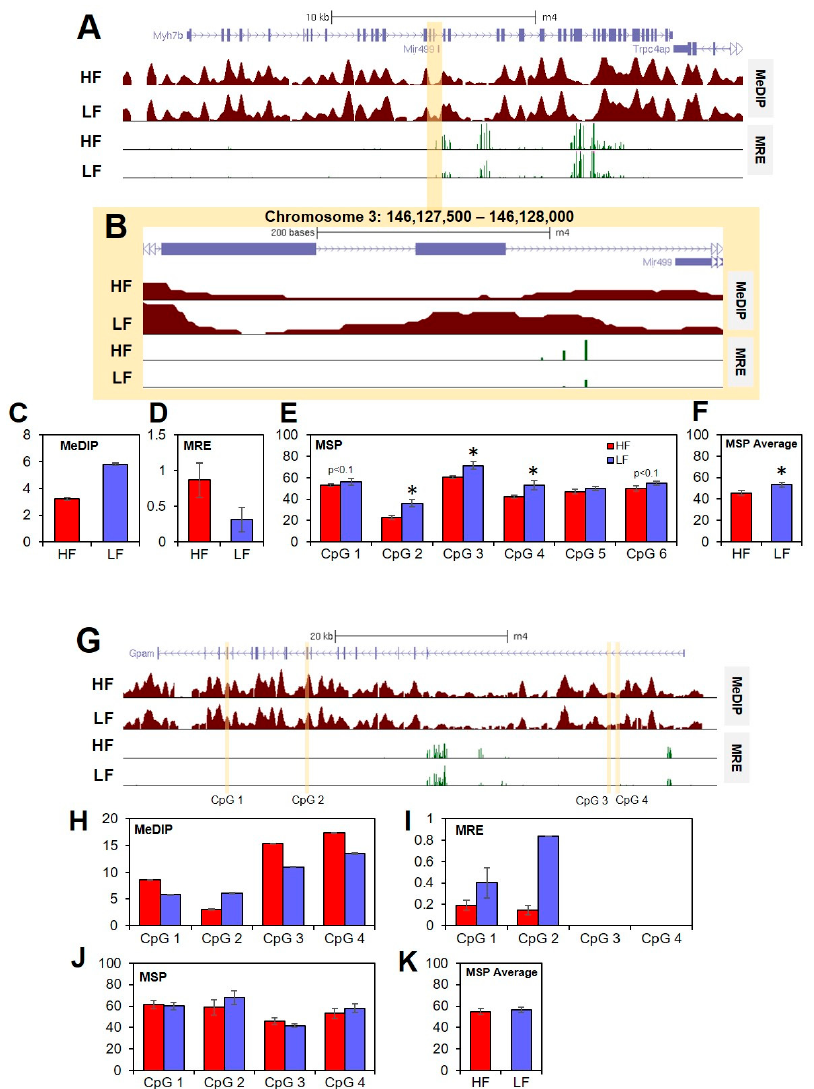
Figure 3 . Methylation Specific PCR validates MeDIP-seq and MRE-seq findings. ( A ) Analysis of